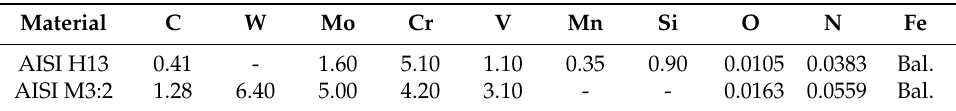
Table 1. Nominal composition of the powders (wt